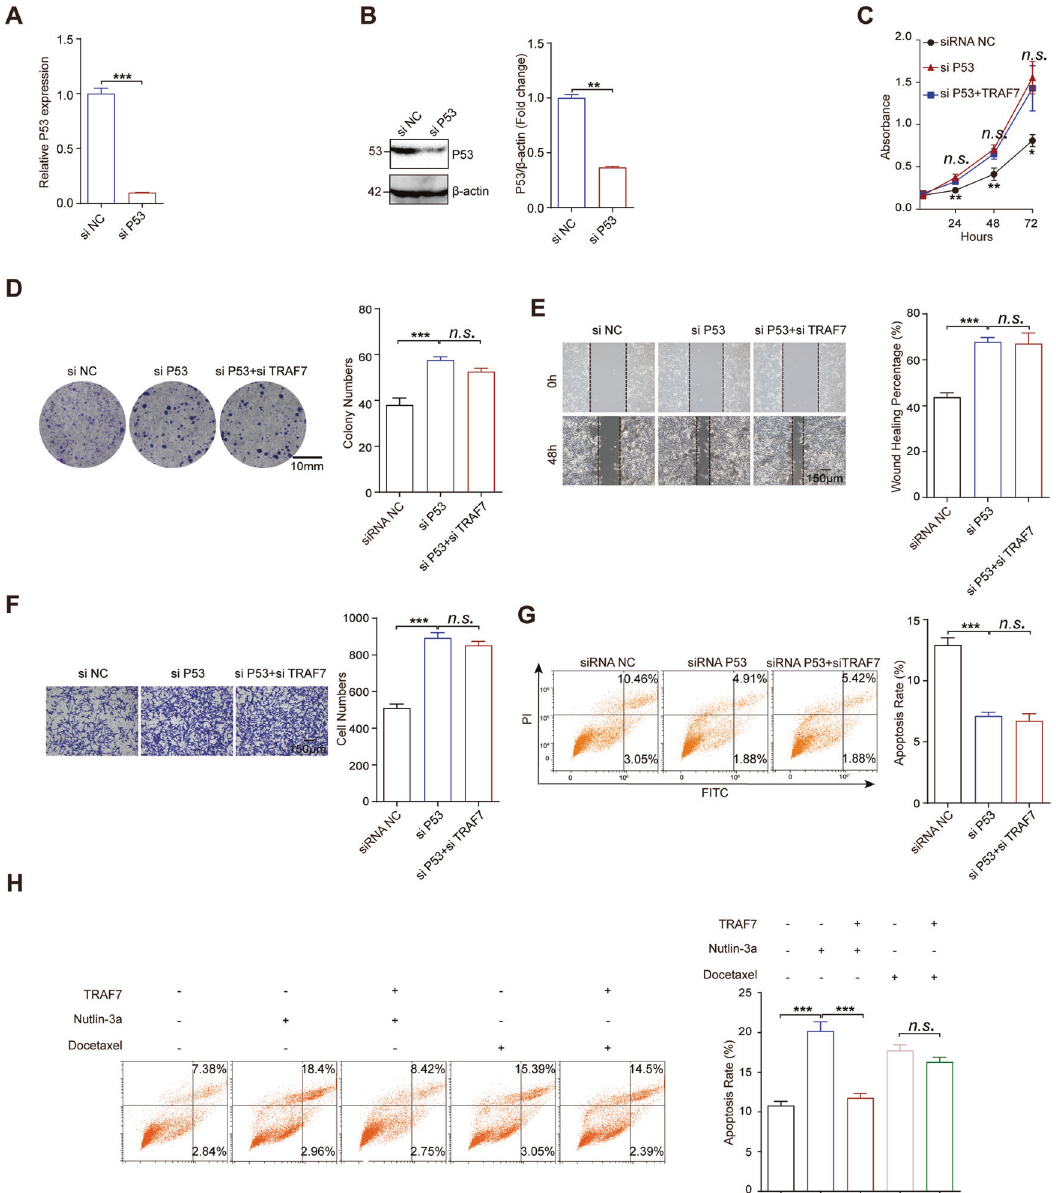
Fig. 5 The function of TRAF7 in HCC cells depends on P53. A , B P53 knockdown ef fi ciency was identi fi ed by qRT-PCR and Western Blot assays in SK-Hep1 cells. C , D CCK-8 and colony formation assays of cells transfected with both siP53 and siTRAF7. E , F P53 knockdown blocked siTRAF7 induced cells migration and invasion changes. G TRAF7 depletion failed to induce cell apoptosis in P53 knockdown SK-Hep1. H The effect of TRAF7 overexpression on nutlin-3a and docetaxel induced apoptosis. All experiments were performed in triplicate. ** p < 0.01; *** p